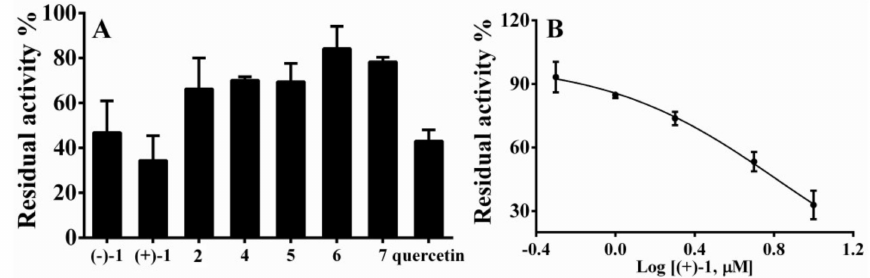
Figure 4. NAT2 inhibition of the